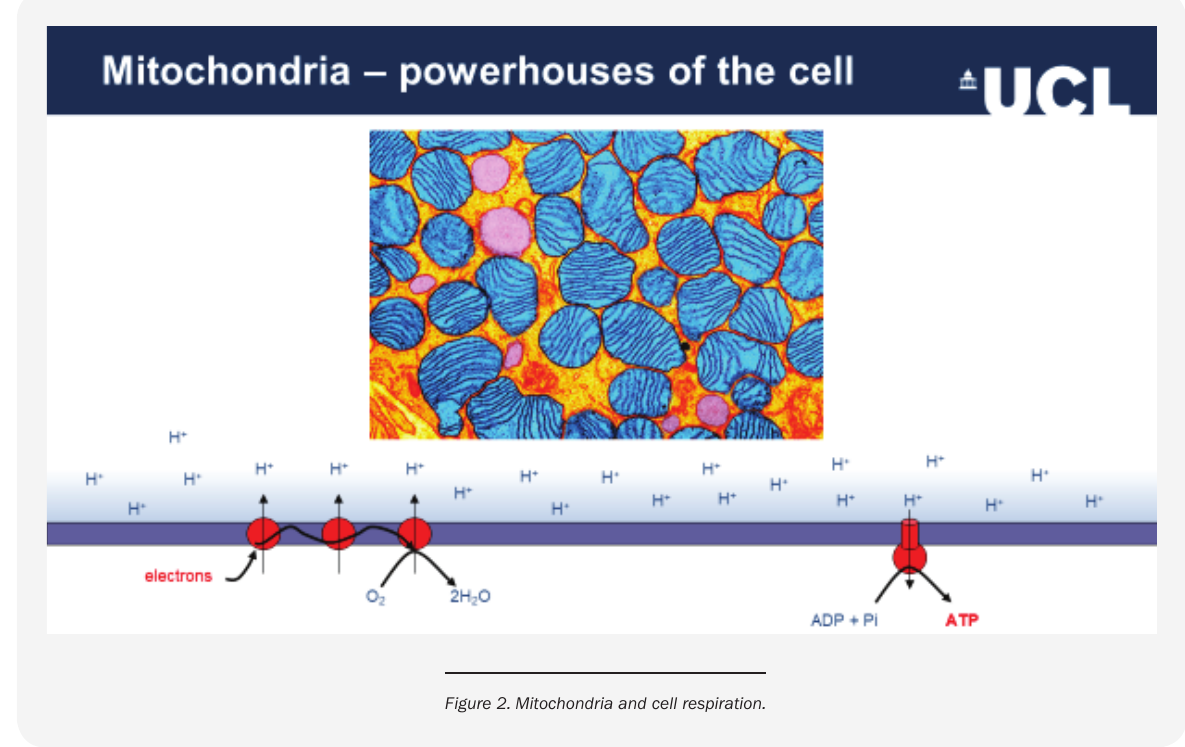
Figure 2. Mitochondria and cell